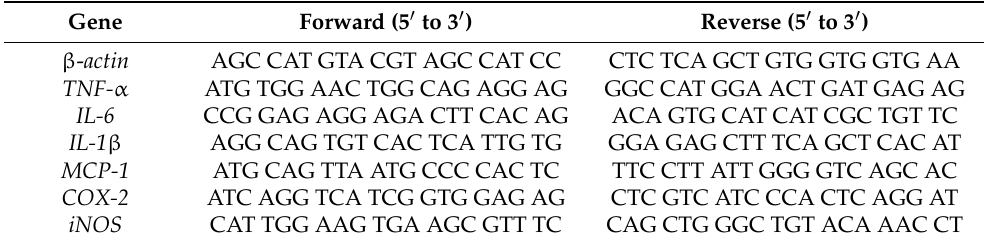
Table 2. Primers used for quantitative real-time polymerase chain reaction